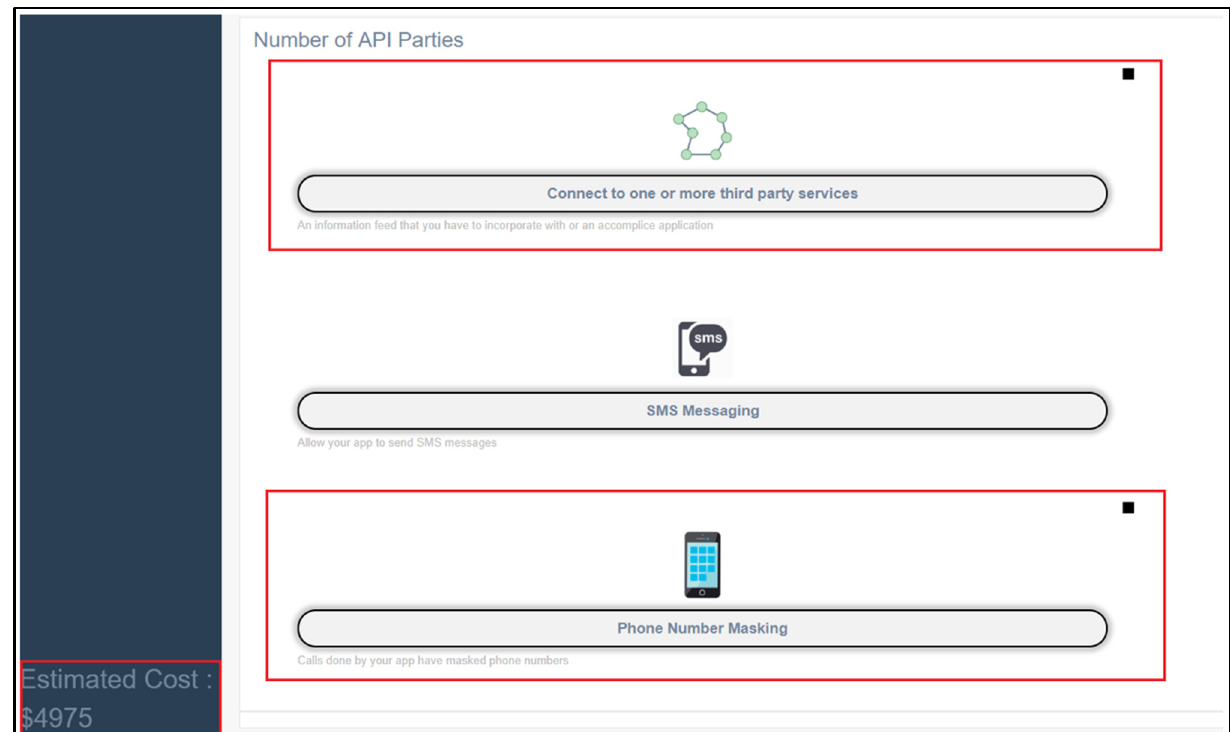
Figure 3. User interface for checkbox function.